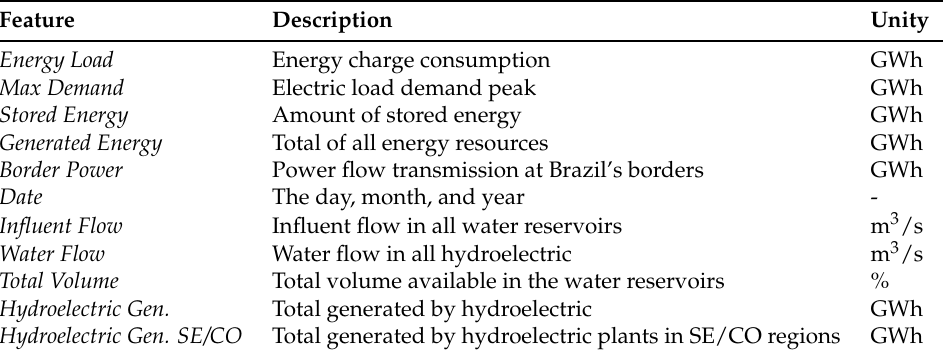
Table 2. Main set of collected data (energy-related